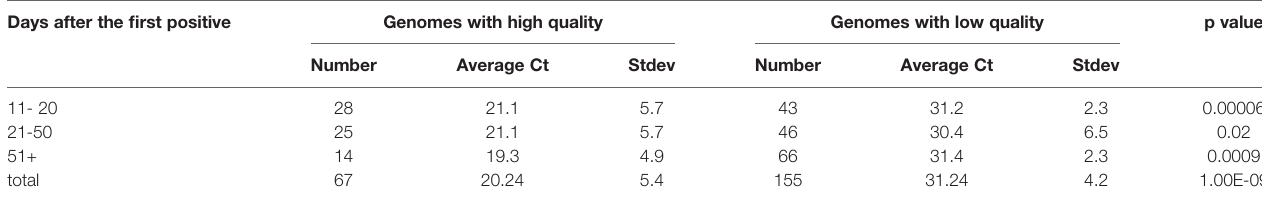
TABLE 1 | Samples with whole genome sequencing data in our cohort of repeats collected 11 days or more after the fi rst